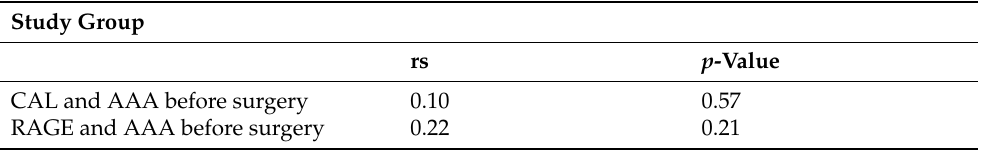
Table 3. The correlations between the results of CAL and RAGE levels and AAA size before surgi- cal treatment.